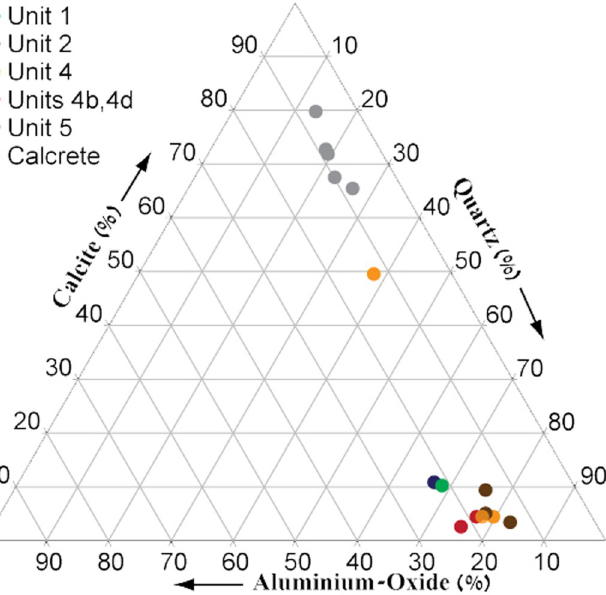
Fig 3. Ternary diagram showing the proportions of the major components in all sample. For full analyses see S2 and S3